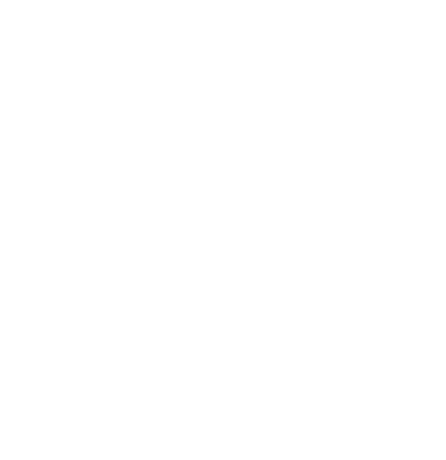
Figure 2. LogP values of four 68 Ga-labeled ligands calculated on the basis of the γ -counter detection results.